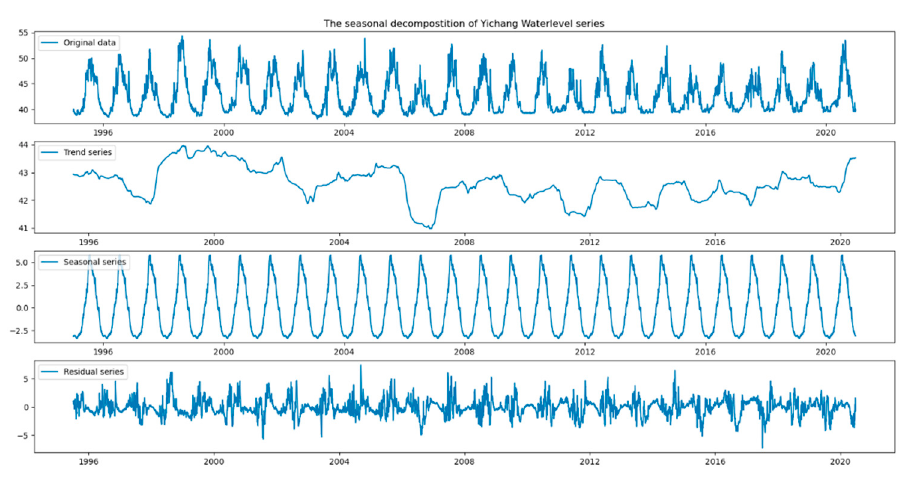
Figure 3. The seasonal decomposition of Yichang water level series.